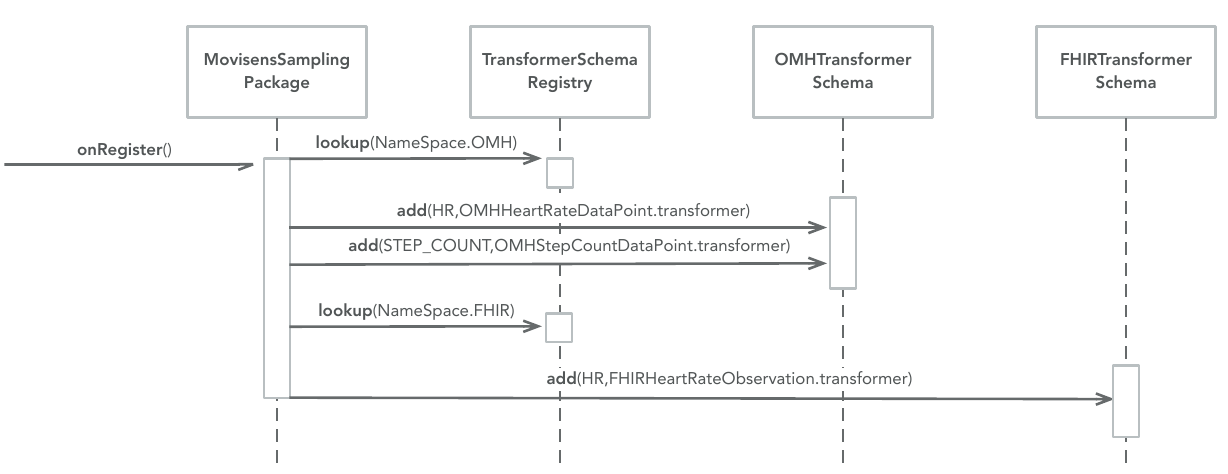
Figure 3. The UML class diagram of the ‘Data Transformer’ pattern with the HR data from the Mo- visens device being transformed into the OMH and FHIR data formats as an example. *: Multiplicity. The dynamic behavior of the data transformer pattern can be divided into two phases: (i) setup and (ii) transformation. Figure 4 illustrates the setup phase. Setup is typically performed in the sampling package upon registration. For each name space, a transformer schema is looked up in the transformer schema registry, and a transformer for relevant data types are added to each schema. Figure 4 shows an example from the Movisens sampling package, which adds three transformers: (i) one that can transform CARP HR data into OMH HR data points, (ii) one that can transform CARP pedometer data into OMH step count data points, and (iii) one that can transform CARP HR data into FHIR HR observations.